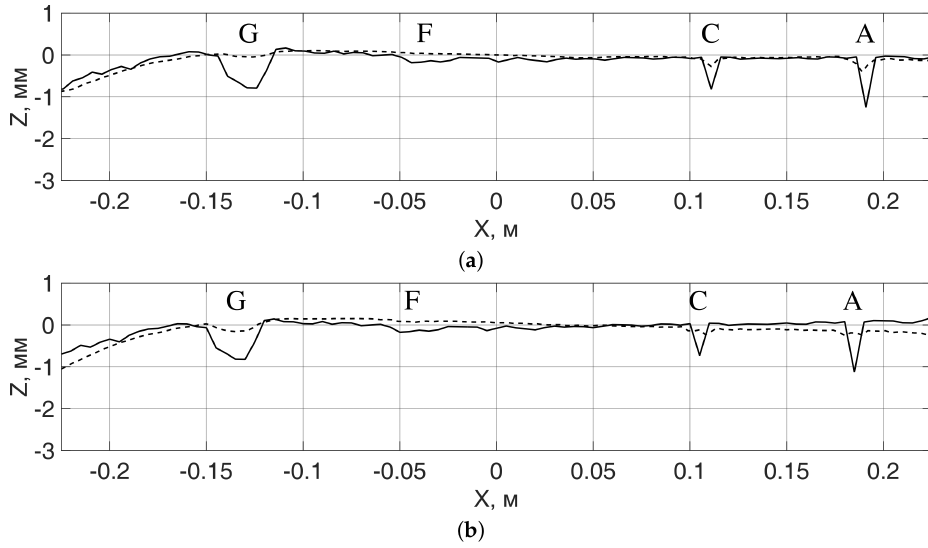
Figure 7. Comparison of contact (solid line) and radar measurements (dashed line) of the surface profile of the rail fragment #1 in the middle line along the rail head: ( a ) both directions of transmit and receive polarizations are along the rail; ( b ) the direction of the transmit polarization is across the rail, the direction of the receive polarization is along the